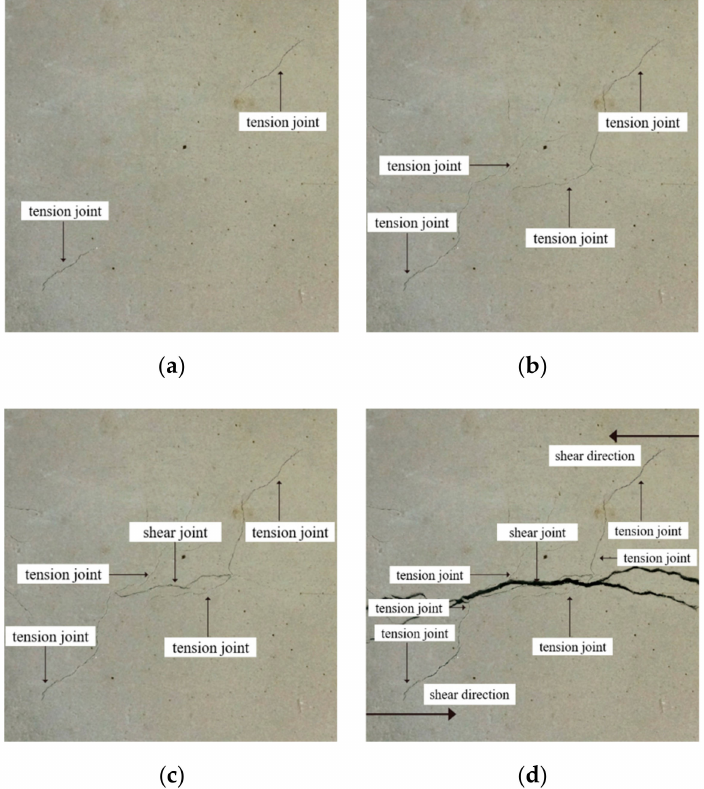
Figure 17. Shear failure of non-collinear cracks specimens. ( a ) Initial failure of the specimen, ( b ) Crack propagation failure, ( c ) Crack penetration failure, ( d ) Final failure of the